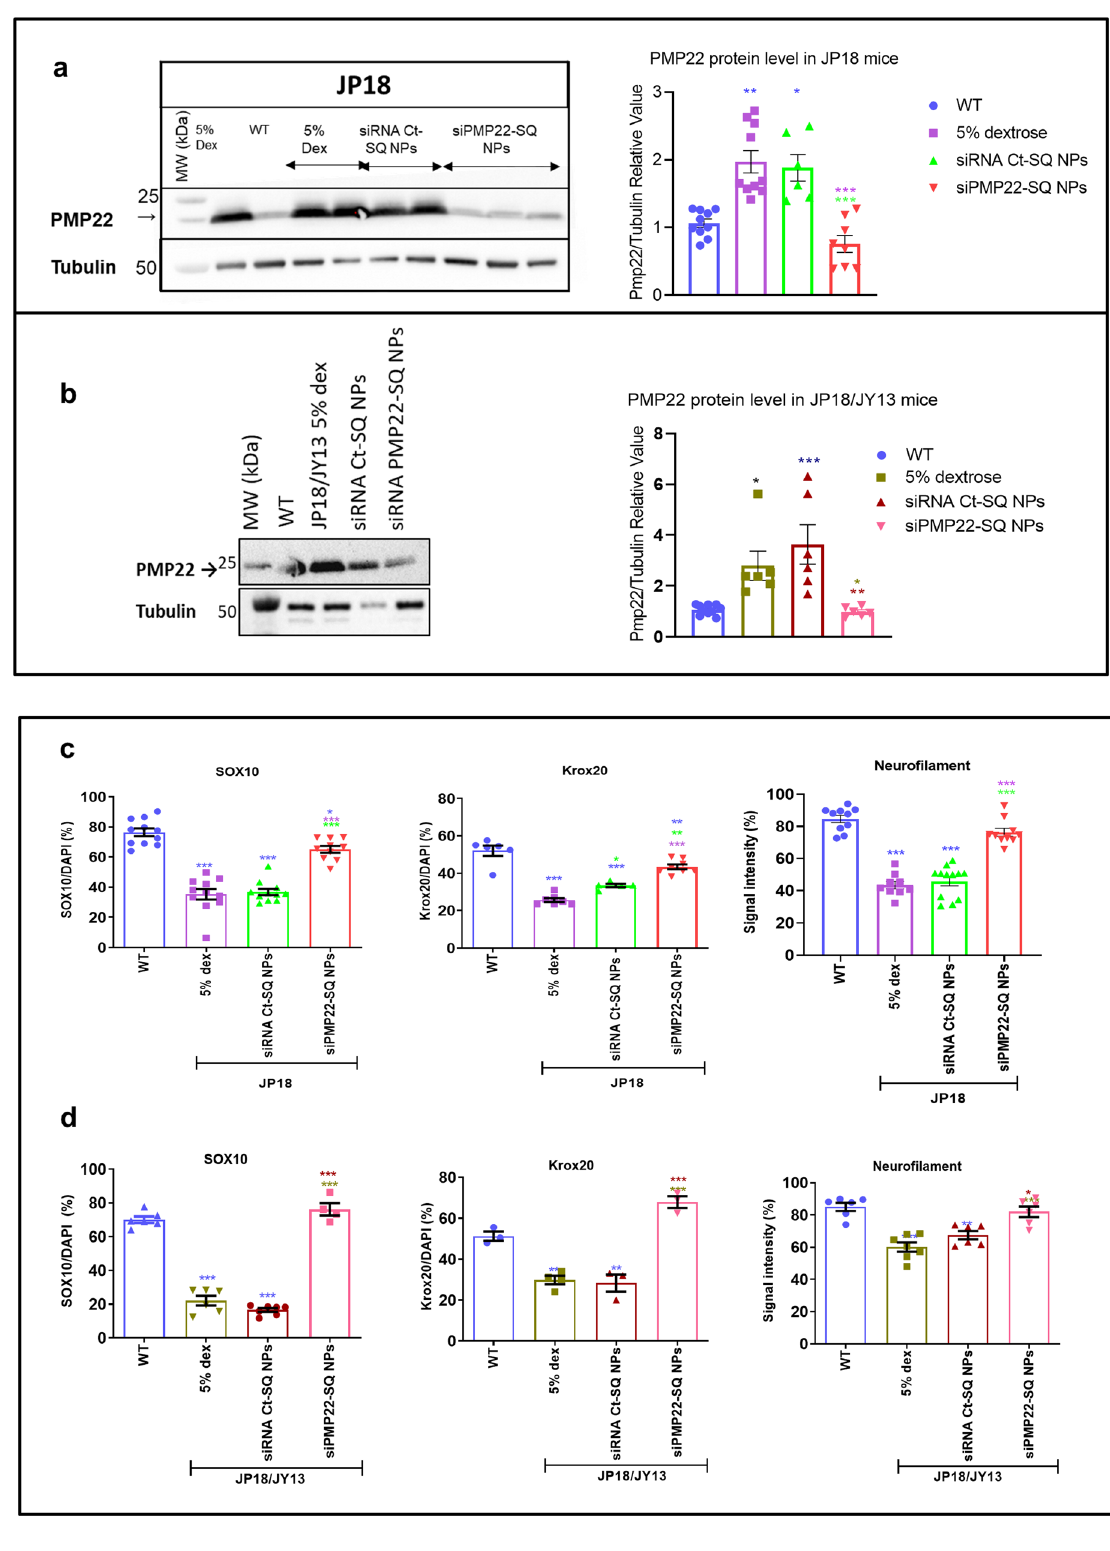
MALDI-TOF mass spectrometry . A MALDI-TOF/TOF Ultra fl eXtreme mass spectrometer (Bruker Daltonics, Bremen) was used for all experiments to verify the identity of the obtained bioconjugates. Mass spectra were obtained in linear positive ion mode. The laser intensity was fi xed just above the ion generation threshold to obtain peaks with the highest possible signal-to-noise (S/N) ratio without a signi fi cant broadening of the peaks. All data were analyzed using the Flex Analysis software package (Bruker